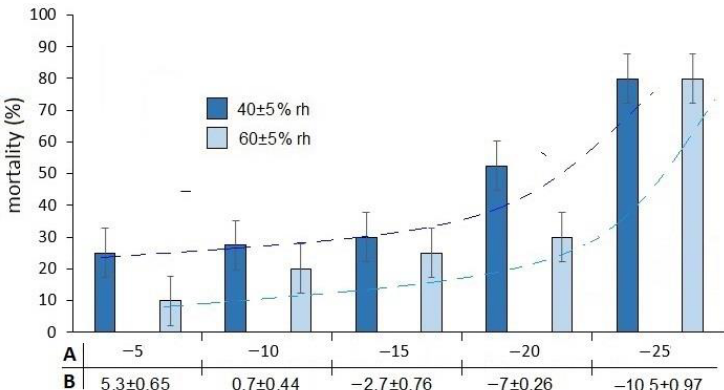
Figure 1. Mortality percentage (mean ± SE) of S. granarius adults (corrected by the Abbott method [27]) treated with two different relative humidity values as a function of the applied tempera- tures with a 75 min exposure time. The dotted lines indicate trends of exponential change. A : applied parallel with the atmospheric temperature